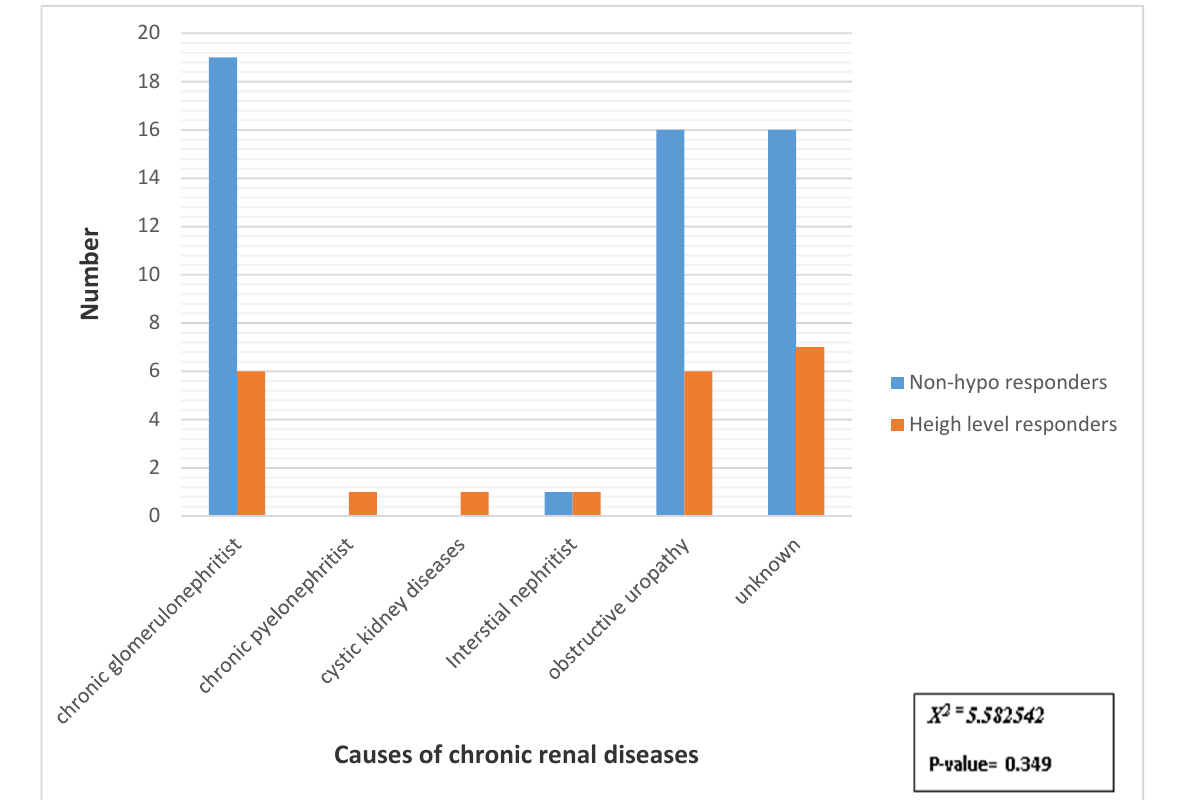
Figure 1. Distribution of samples studied according to immunological response to HBV in relation to causes of chronic renal diseases. X 2 = Chi-square